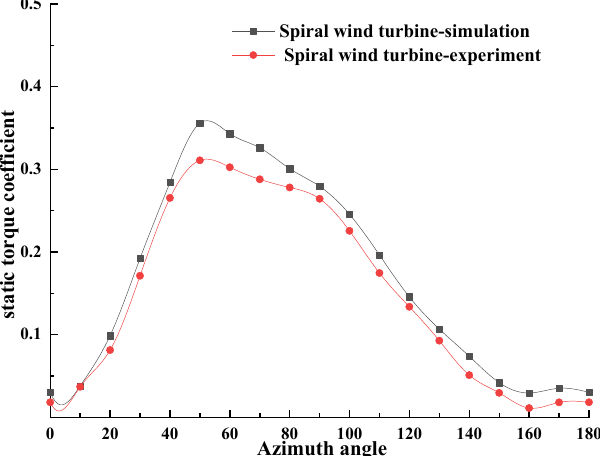
Figure 6. Comparison of the experiment with the numerical results.